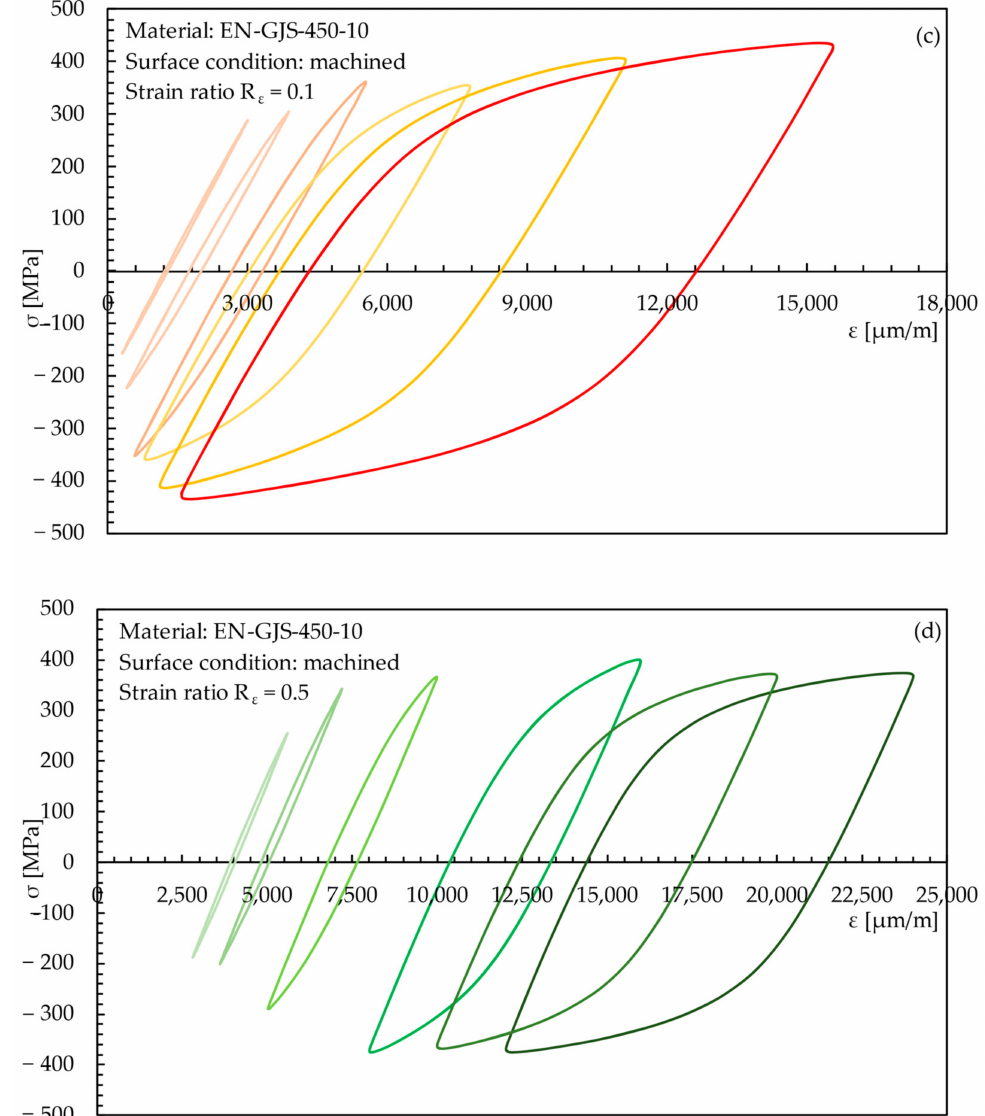
Figure 11. Half-life hysteresis loops of EN-GJS-450-10 tested under R ε = -1 in the ( a ) machined and ( b ) as-cast conditions; ( c ) R ε = 0.1 and ( d ) R ε = 0.5 in the machined conditions. For comparison purposes, the figures relevant to R ε = − 1 include the monotonic static curve, according to Equation (2) and the parameters of Table 5, and the cyclic stress-strain curves, according to Equation (4) and the parameters fitted by both the non-compatible and the compatible